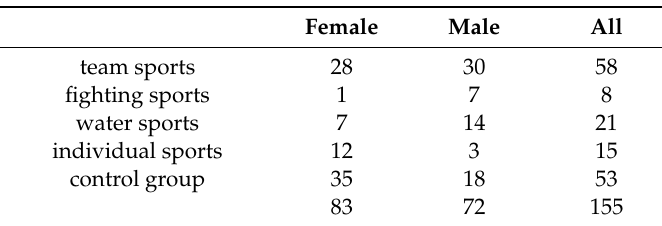
Table 1. Distribution of students by type of sport.